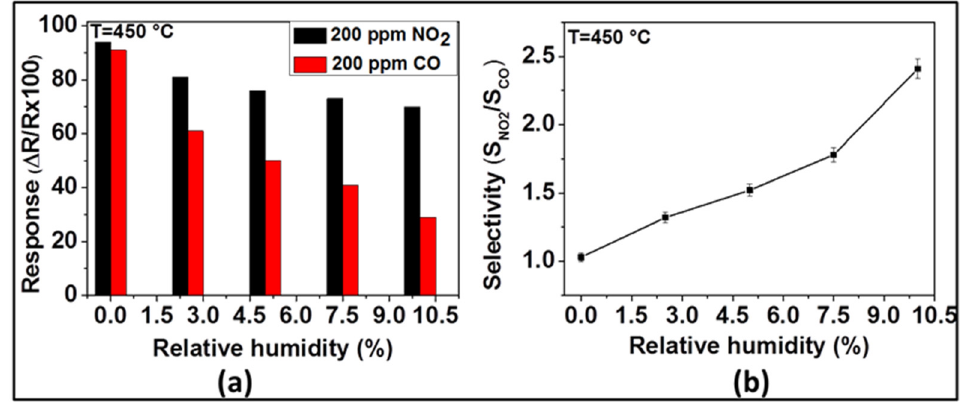
Figure 7. Response of ZnO thin film to 200 ppm of NO 2 and CO ( a ) and its selectivity (S NO2 /S CO ) ( b ) at 450 °C in the presence of different relative humidity.